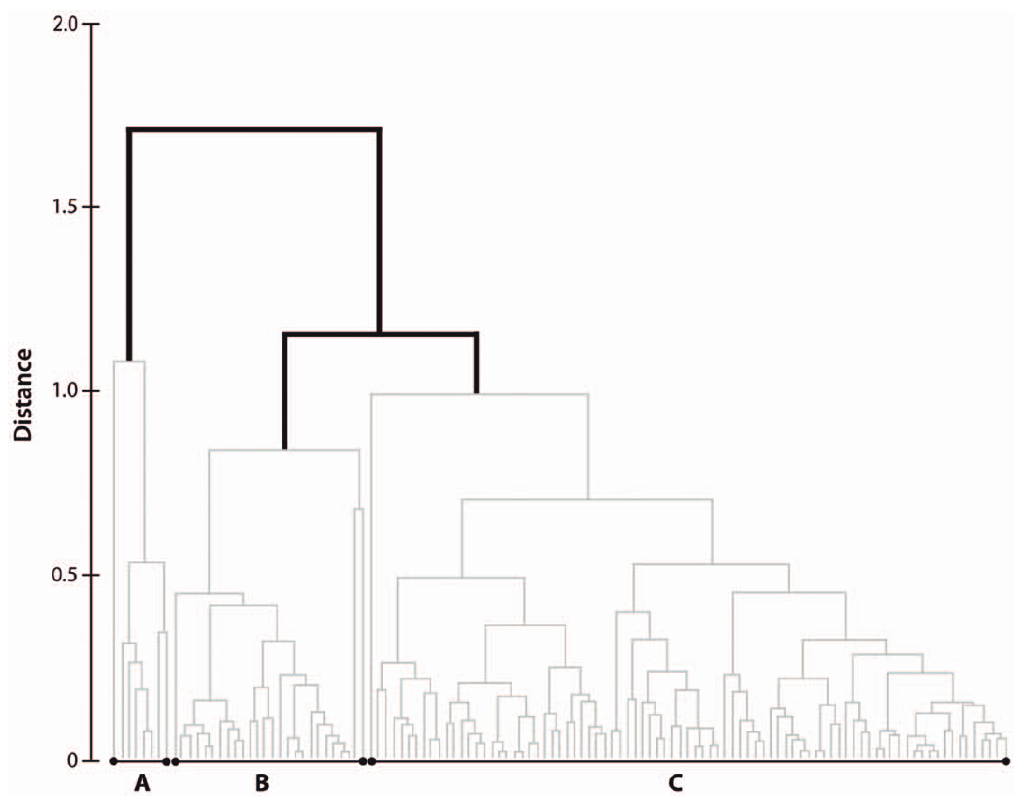
Figure 3. Classification of settlers’ otolith cores. Thin grey lines indicate non-significantly different samples, thick dark lines separate significantly different groups (named by letters A, B and C).